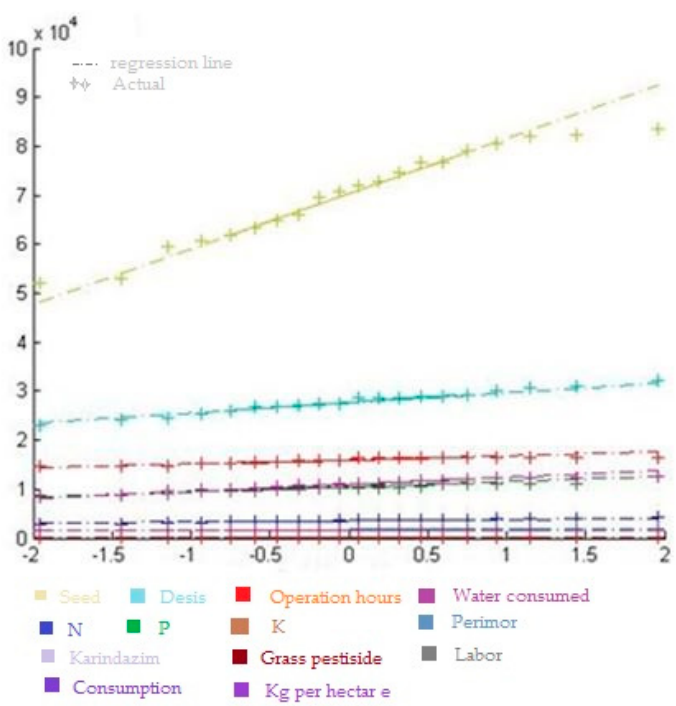
Figure 5. Quantile-Quantile (QQ) plot of sample data versus standard normal.